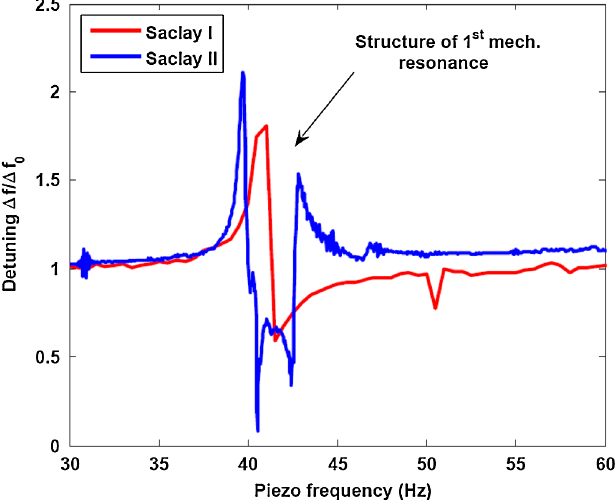
FIG. 12. (Color) Comparison of the transfer functions of the type I and II tuner mounted on the same cavity in the range of 30–60 Hz. Depending on the tuner a single or double pair of resonance and antiresonance occurs as the lowest mechanical eigenmode.